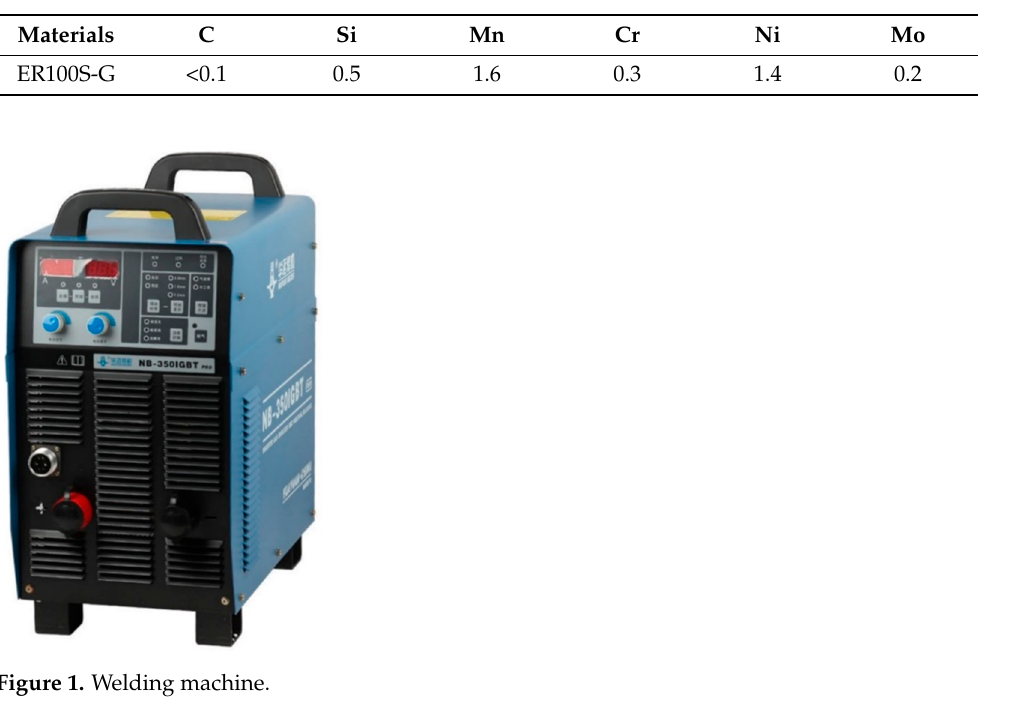
Table 2. Chemical compositions of ER100S-G (wt.%).